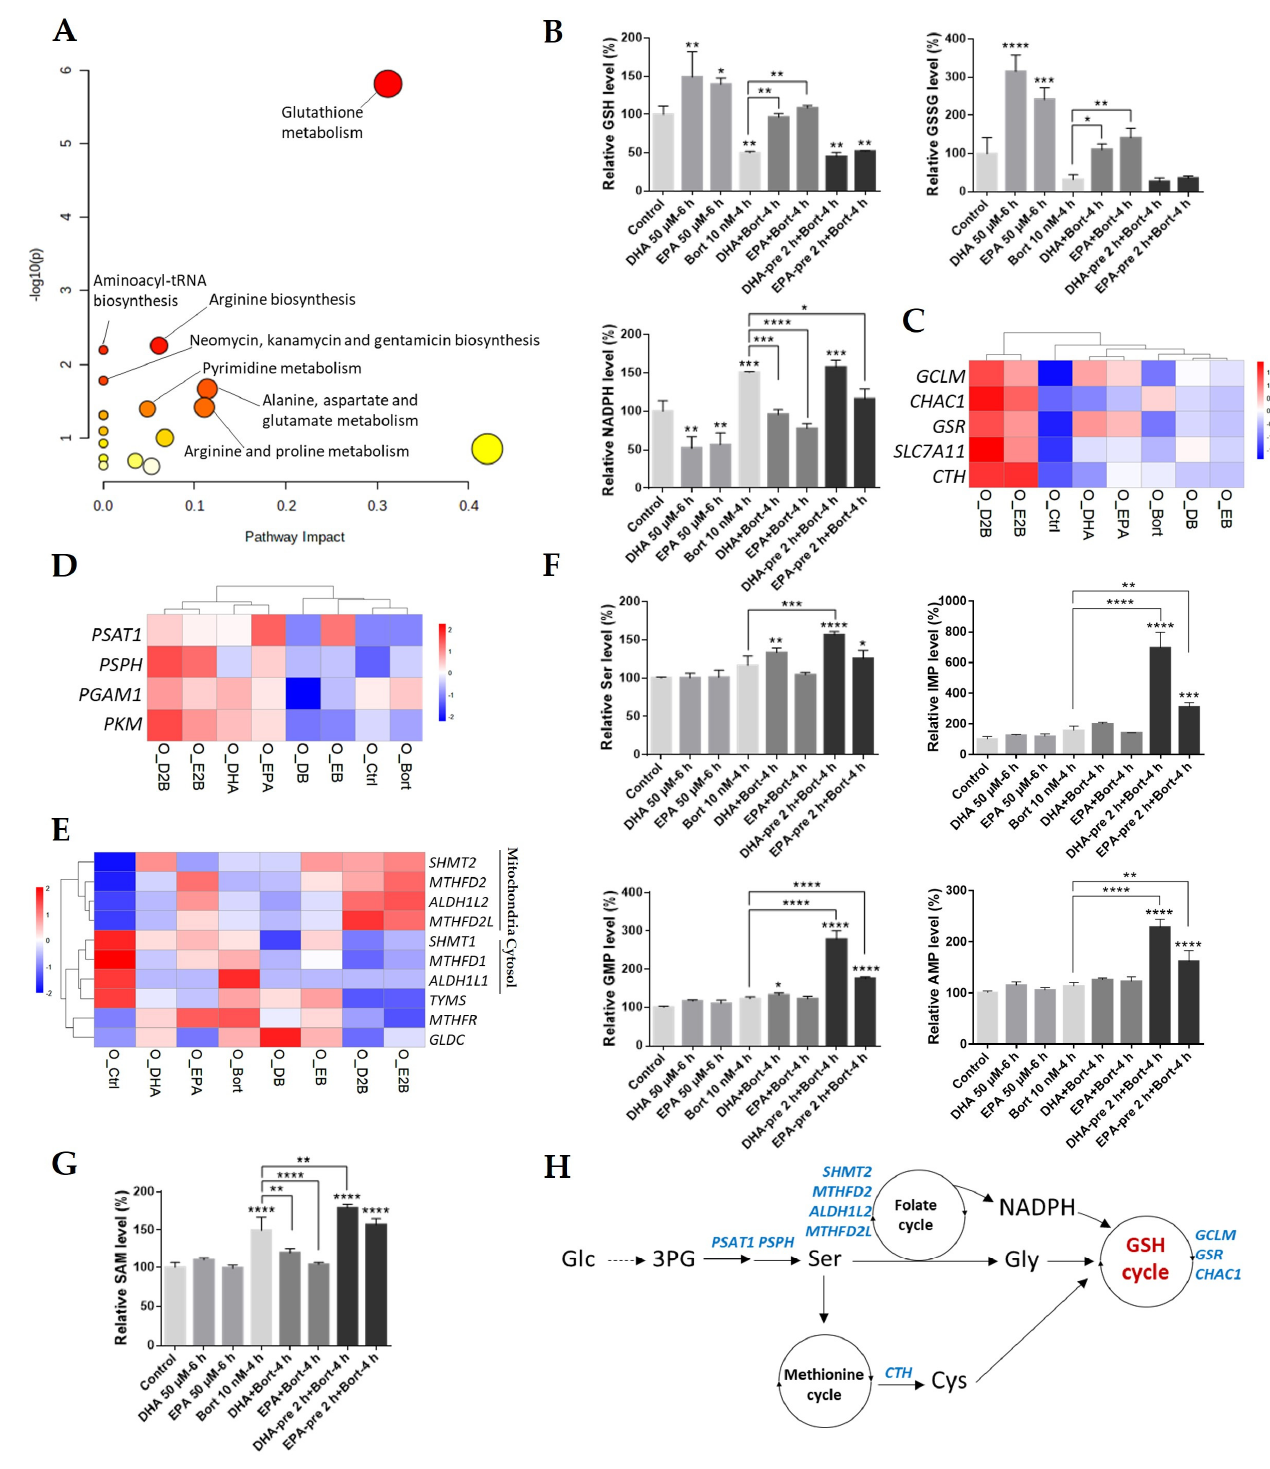
Figure 4. Transcriptomic and metabolomic analysis in the OPM2 cell line reveals the crucial role of GSH metabolism in increasing bortezomib chemosensitivity in MM. For metabolomic analysis, OPM2 cells were pretreated with 50 µM of DHA/EPA for 0 or 2 h, then bortezomib (10 nM) was added for 6 h treatment. ( A ) Metabolome pathway enrichment of 16 differentially regulated metabolites using MetaboAnalyst 5.0. The node color represents the p values, and the node size represents the pathway impact values. ( B ) The levels of GSH, oxidized GSH (GSSG) and NADPH upon different treatment. Heatmap analysis of the expression of the key enzymes involved in GSH metabolism ( C ), serine synthesis and metabolism ( D ) and folate cycle ( E ) in different conditions. ( F ) and ( G ) The levels of metabolites related to folate cycle and methionine cycle in different conditions. Data are presented as mean ± SD of three independent treatment. * p < 0.05, ** p